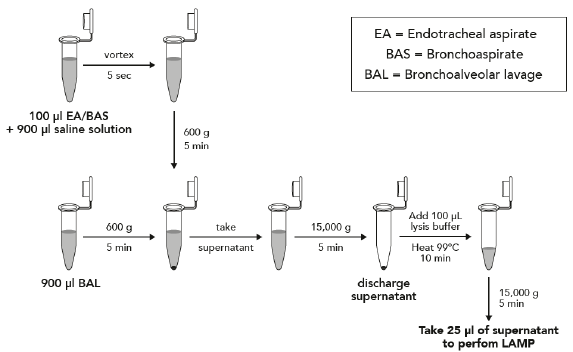
Figure 1. Sample preparation workflow for bronchoalveolar lavage (BAL) and bronchoaspirate/endotracheal aspirate (BAS/EA).